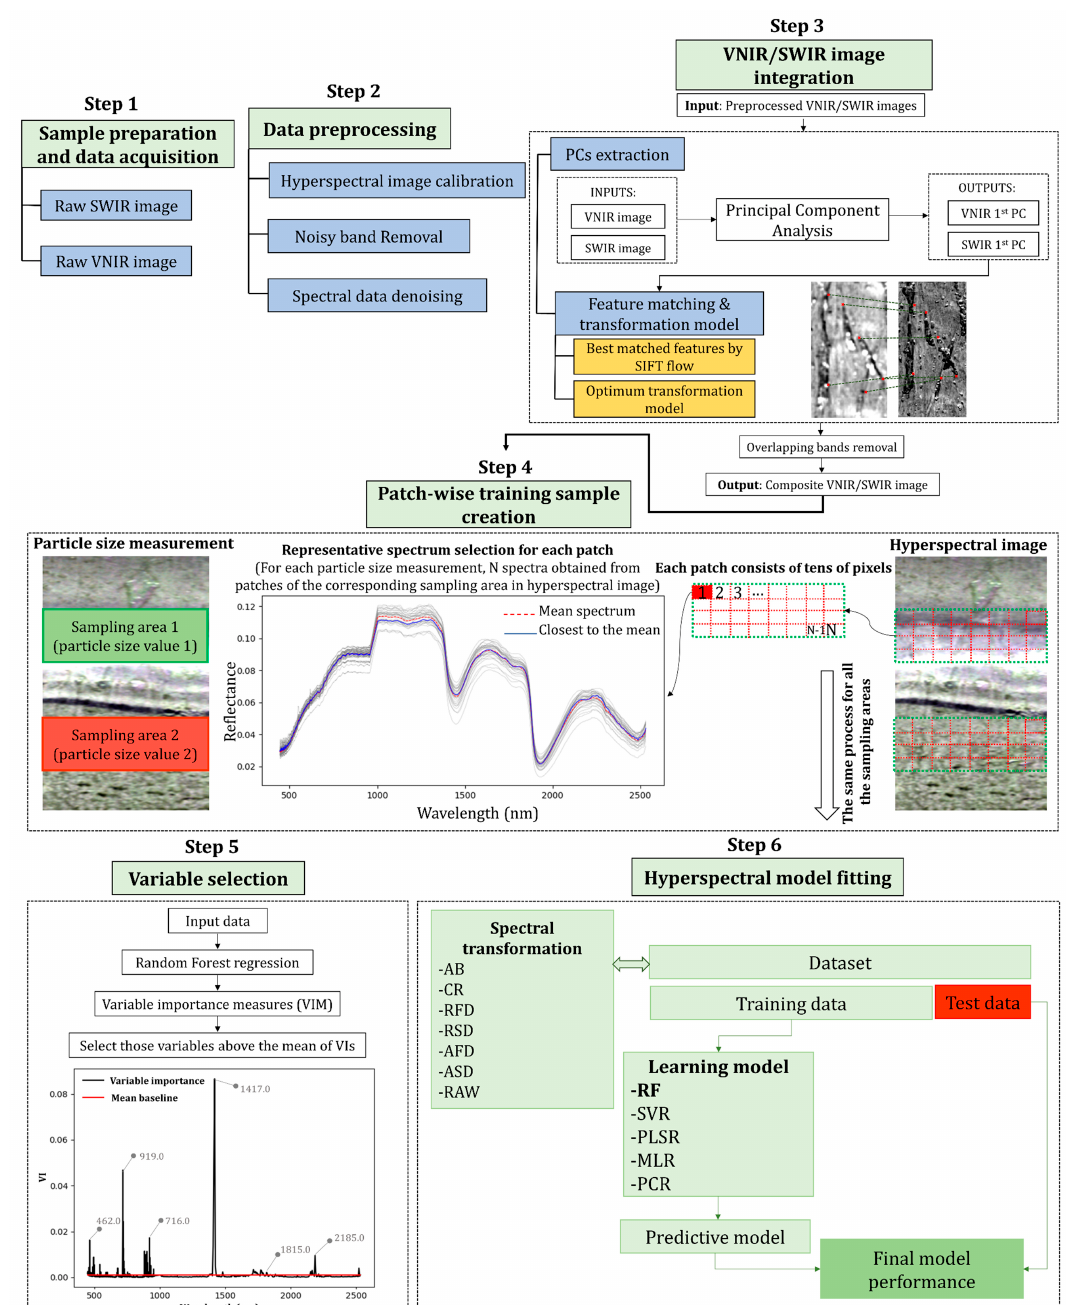
Figure 1. Schematic diagram of the proposed workflow for model development.